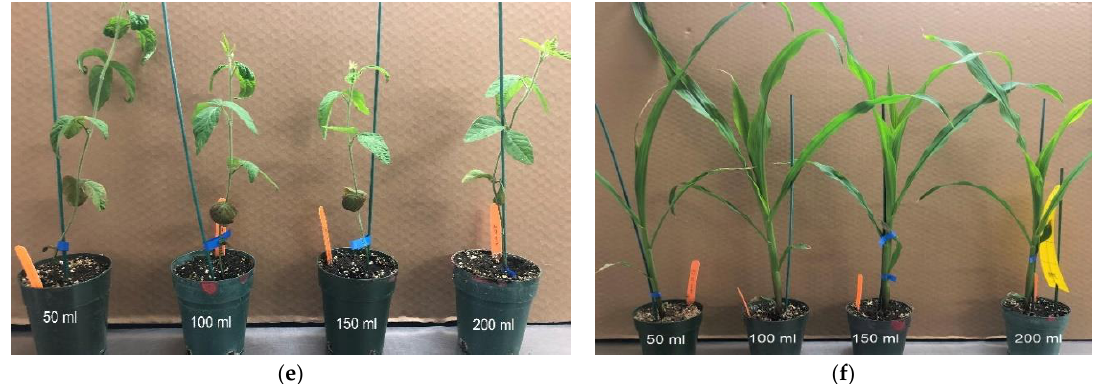
Figure 3. ( a ) Greenhouse-controlled environment. ( b ) Scanning the leaf using the proposed device. Sample pots of ( c ) canola and ( d ) wheat subjected to four levels (0 g∙L, 6 g∙L, 12 g∙L, and 20 g∙L) of N fertilization. Sample pots of ( e ) soybean and ( f ) corn subjected to four levels (50 mL, 100 mL, 150 mL, and 200 mL) of water application.